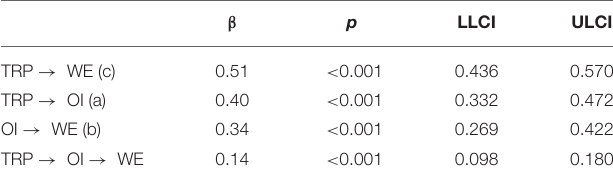
TABLE 3 | Mediating effect of organizational